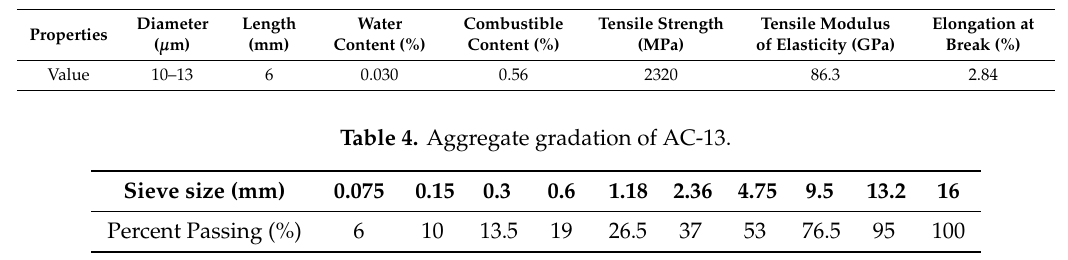
Table 3. Properties of basalt fibers.